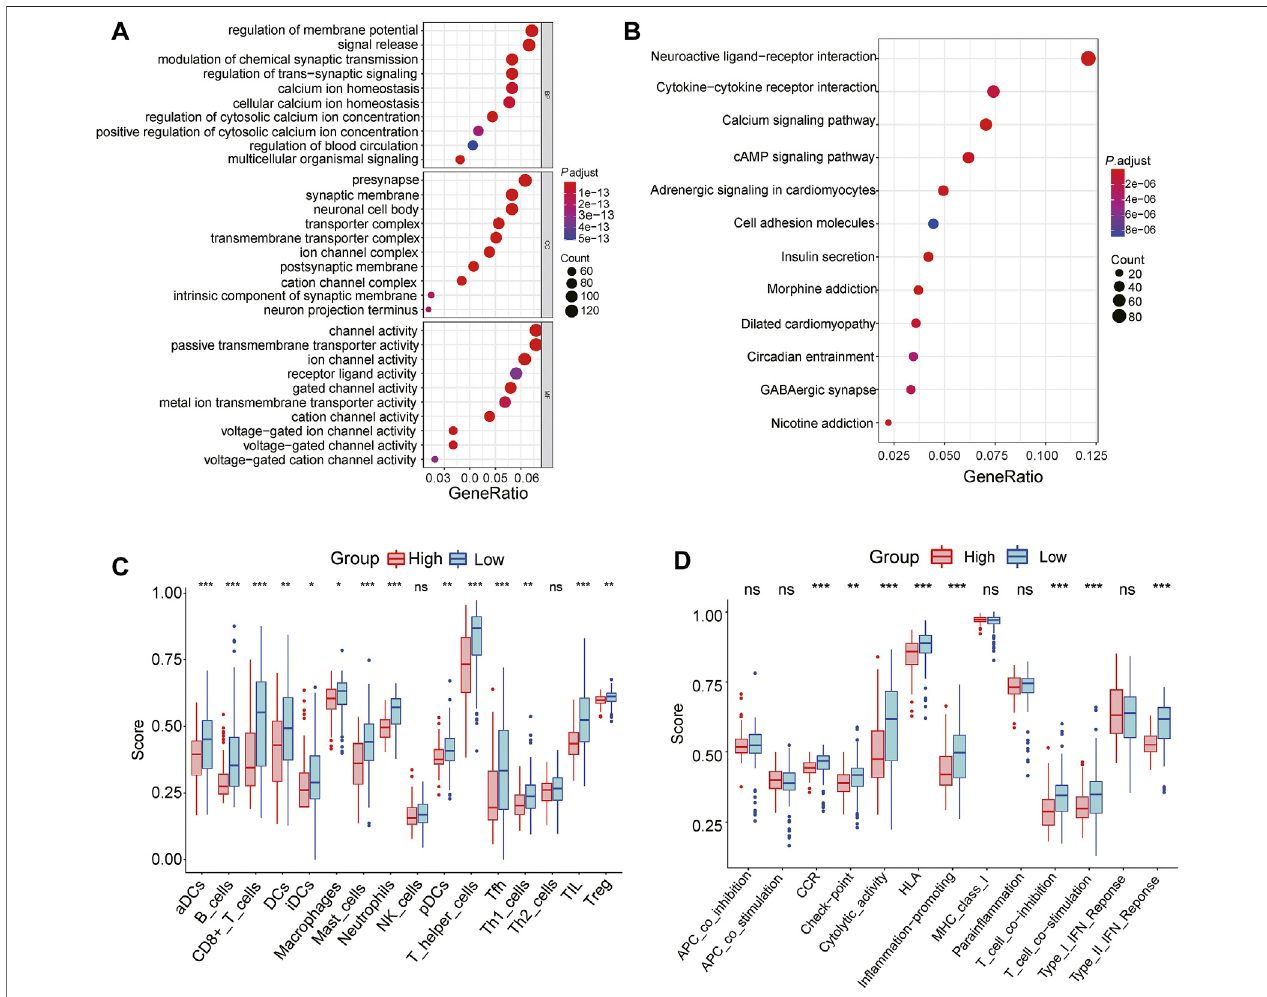
FIGURE 7 | Functional analyses of the 3-gene signature in the TCGA cohort (A) GO enrichment analysis of DEGs between the high and low-risk group, BP: Biological process; MF: Molecular function; CC: Cellular components (B) KEGG enrichment analysis of DEGs between the high-risk group and low-risk group (C) The difference in the enrichment scores of 16 types of immune cells between two risk subgroups (D) The difference of enrichment scores of 13 types of immune pathways between two risk subgroups. * represents p < 0.05; ** represents p < 0.01; *** represents p < 0.001.